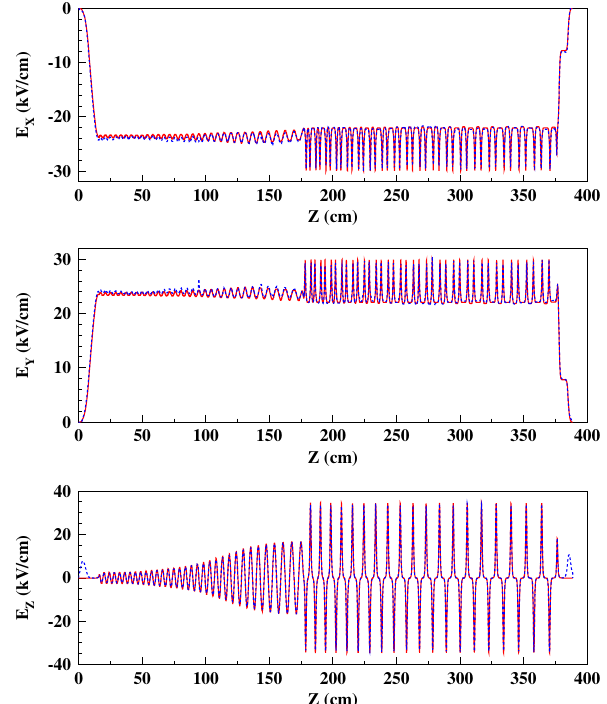
FIG. 8. Comparison of the electric field components along the RFQ at mid aperture between the cell-by-cell 3D model (solid red) and the full-cavity 3D model (dashed blue) for the final trapezoidal